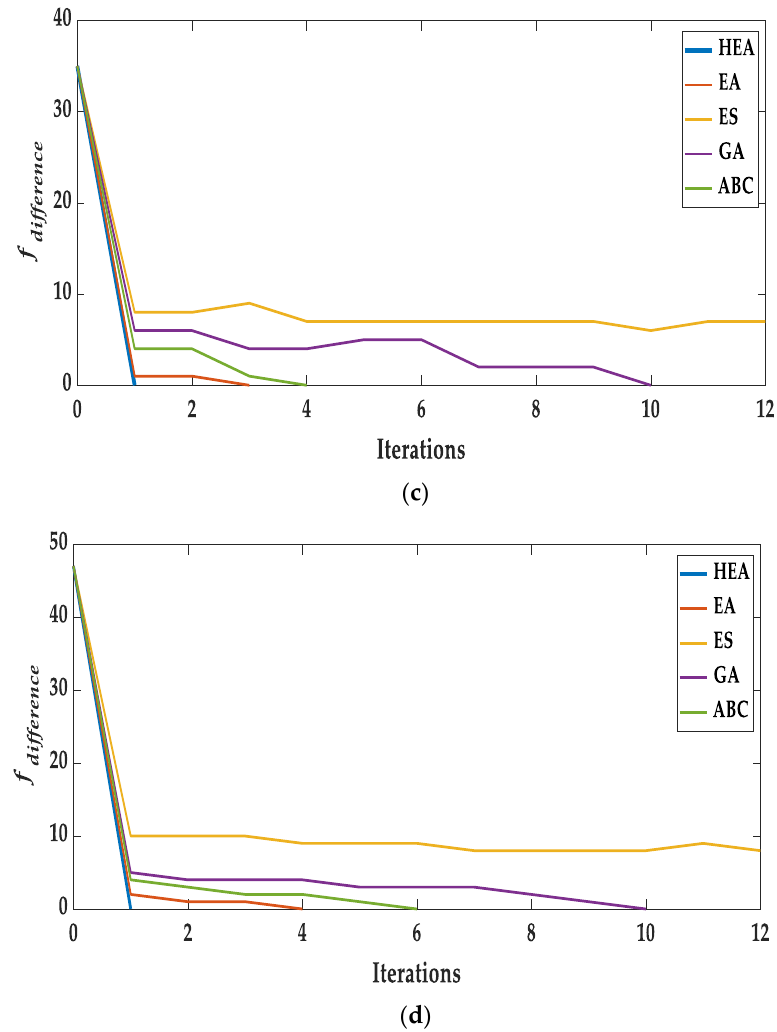
Figure 12. ( a ) Convergence curves for NN = 30 in different DHNNRAN k SAT models. ( b ) Con- vergence curves for NN = 60 in different DHNNRAN k SAT models. ( c ). Convergence curves for NN = 90 in different DHNNRAN k SAT models. ( d ) Convergence curves for NN = 120 in different DHNNRAN k SAT models.